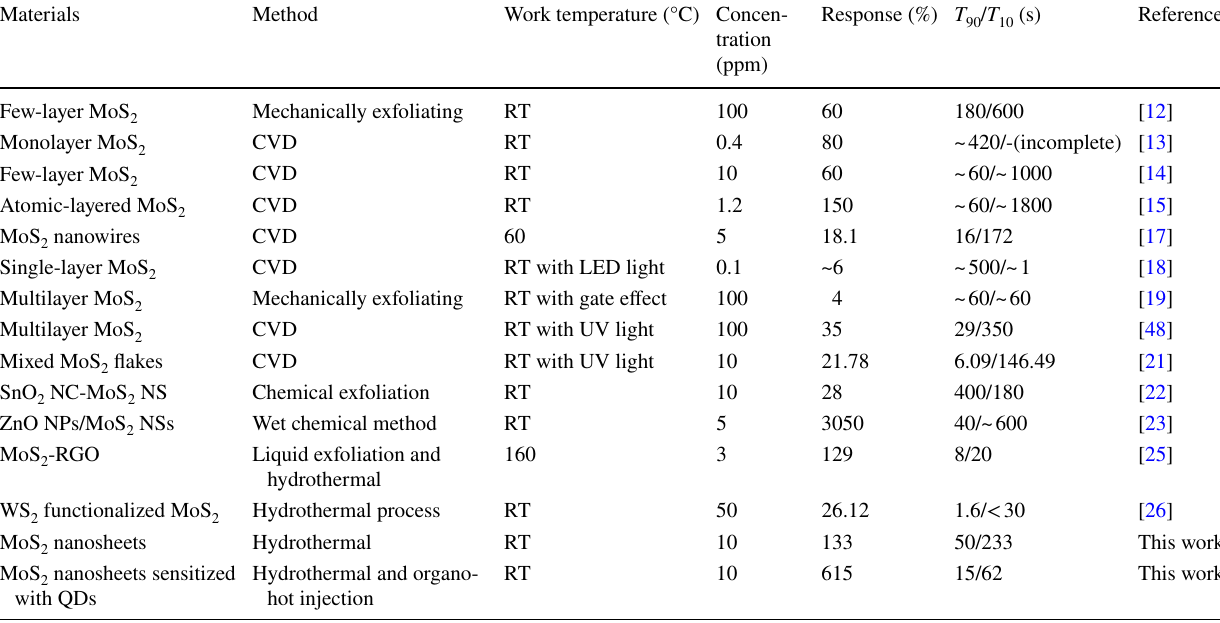
Table 1 NO 2 ‑sensing performance of MoS 2 ‑based sensors